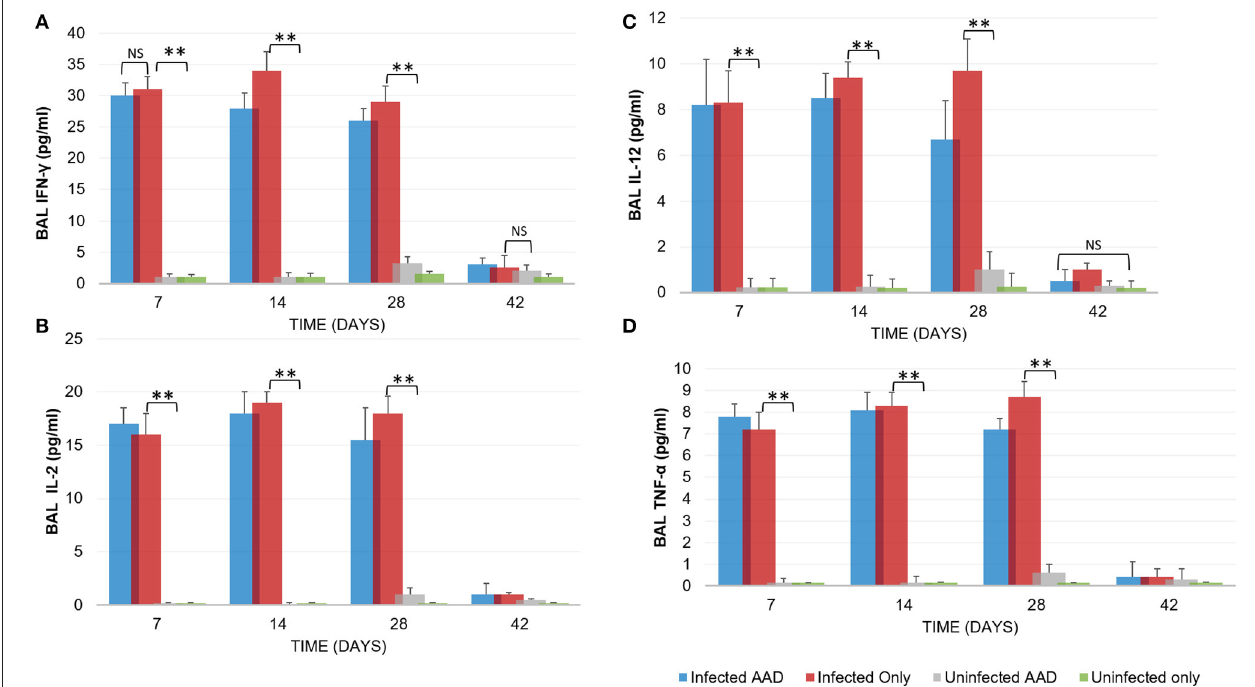
FIGURE 3 | Th1 cytokine levels during chlamydial infection and AAD induction. Infected animals displayed a robust Th1 cytokine response (IFN- γ , IL-2, IL-12, TNF- α , (A–D) , respectively; N = 5 animals per group) in response to chlamydial infection. Infected mice cleared the infection after 28 days. Uninfected and AAD induced animals did not produce Th1 cytokines. Cytokine production was significantly reduced by day 42, coinciding with clearance of infections. ** P < 0.0001 for uninfected controls compared to infected animals; NS is p = not significant. There was no significant difference in cytokine levels between infected only and infected AAD animals. Results are representative of 2 independent